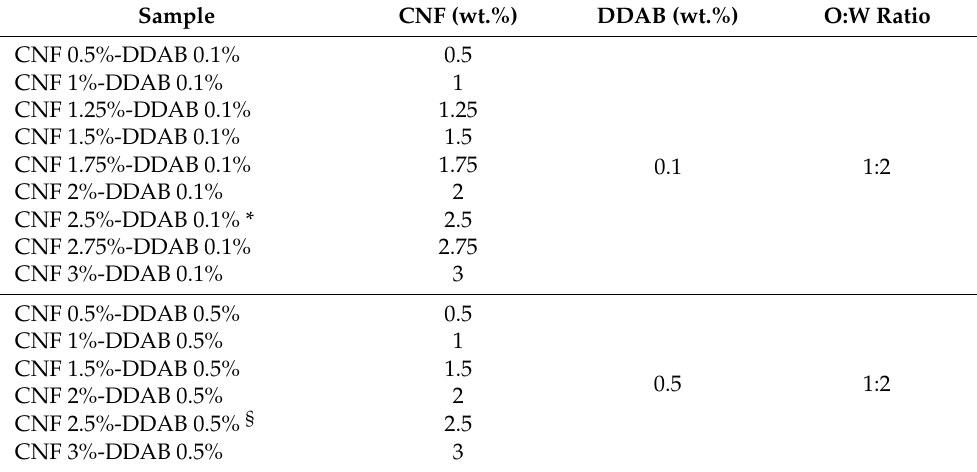
Table 1. Composition of analyzed CNF